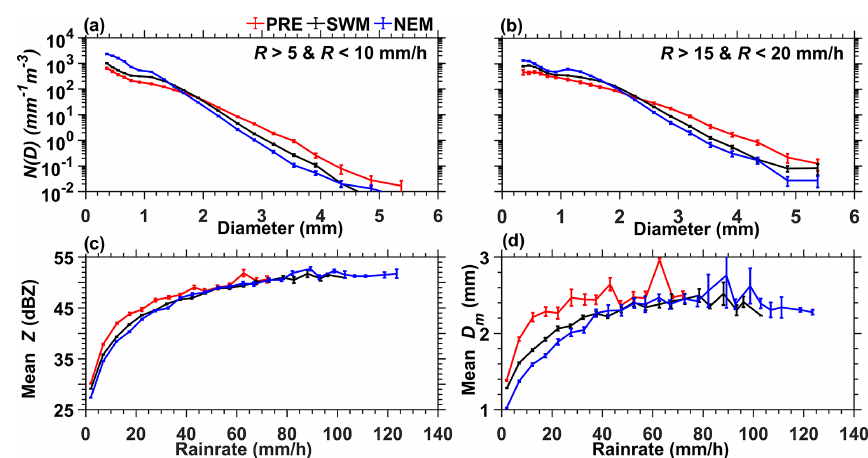
Figure 1. Seasonal mean DSD variation between the three seasons for two rain rate intervals, i.e., (a) 5–10 and (b) 15–20mmh − 1 . Variation of (c) mean Z and (d) mean D m with R during different seasons. The data within each rain rate interval are averaged to obtain mean values. The error bar represents the standard deviation of the mean in each rain rate interval.